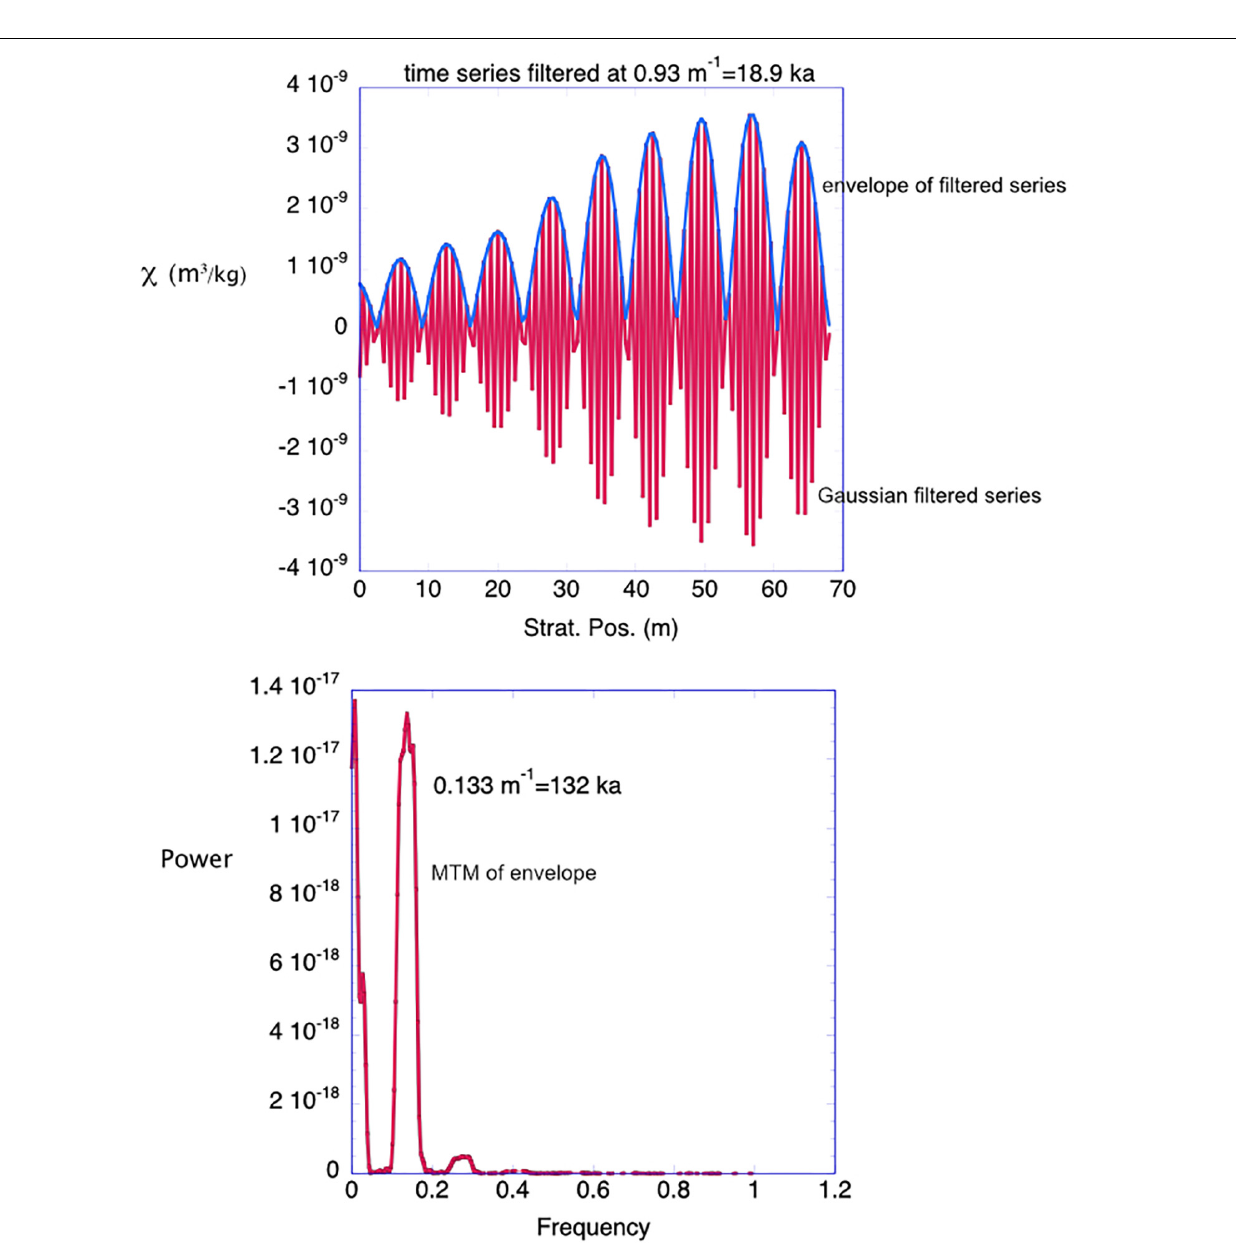
FIGURE 7 | Amplitude modulation (AM) test conducted on the frequency chosen for precession in our results. (Top) The Kappabridge time series was filtered at the frequency of the spectral peak chosen to be precession (0.93 m − 1 ) and the envelope of the amplitude variation yields a power spectrum (Bottom) with a significant peak at the frequency we have chosen as short eccentricity (0.133 m − 1 ). This result strongly supports our assignment of Milankovitch frequencies to the spectral peaks observed in our